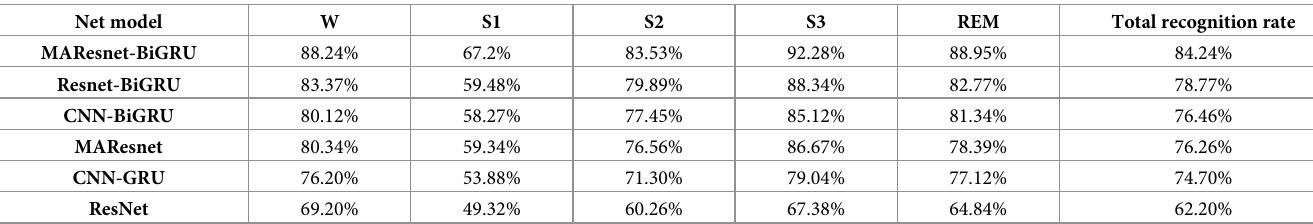
Table 2. Recall rate of each sleep stage classification under different algorithms under label smoothing on Sleep-EDF dataset. Net